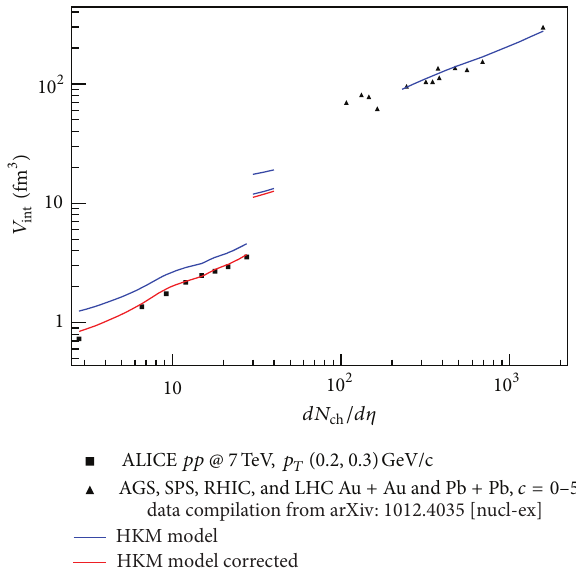
Figure 7: The interferometry volume dependency on charged particles multiplicity. The curve fragments in the middle correspond to the HKM prediction for 𝑝 + 𝑃𝑏 collision at the LHC energy √𝑠 = 5.02 GeV.Theupperoneisrelatedtotheinitialtransversesystemsize 𝑅 = 1.5 fm and for the two lower ones 𝑅 = 0.9 fm. The curves at the left and at the right represent the HKM results for 𝑝 + 𝑝 and 𝐴 + 𝐴 central collisions respectively, compared to the experimental data at AGS, SPS, RHIC, and LHC, taken from papers [42, 80–87]. The 𝑅 𝑅 𝑝𝑝 volumes are calculated as a product 𝑅 of respective out side long experimental radii. The blue lines correspond to pure HKM results, whereas the quantum corrections to them are presented by the red lines. Figure is taken from